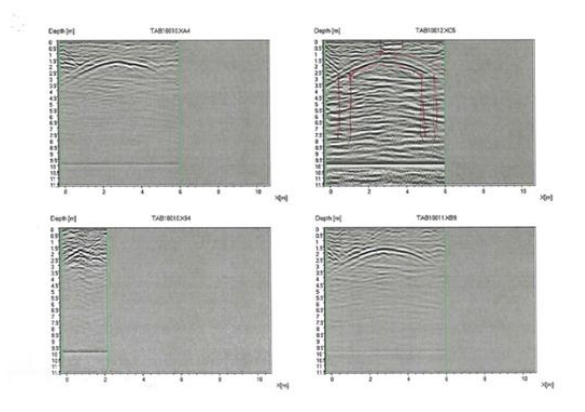
Figure 5. B-scan raw profile (GPR).and B-scan focused using the algorithm Diffraction